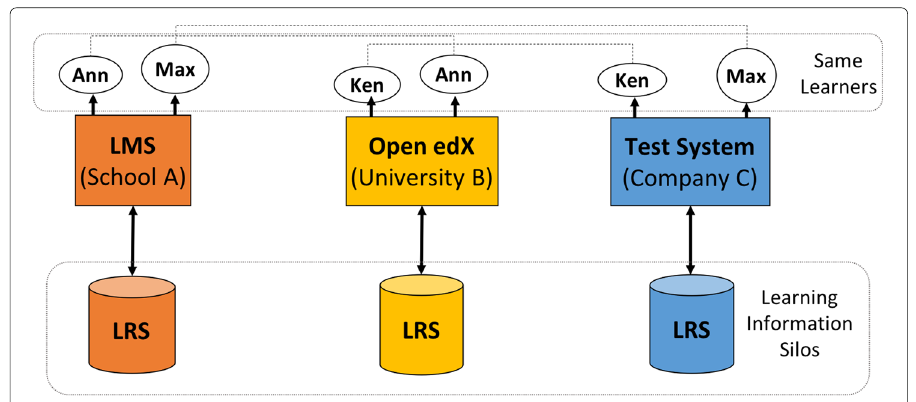
non-transferable across these learning systems even when the users want